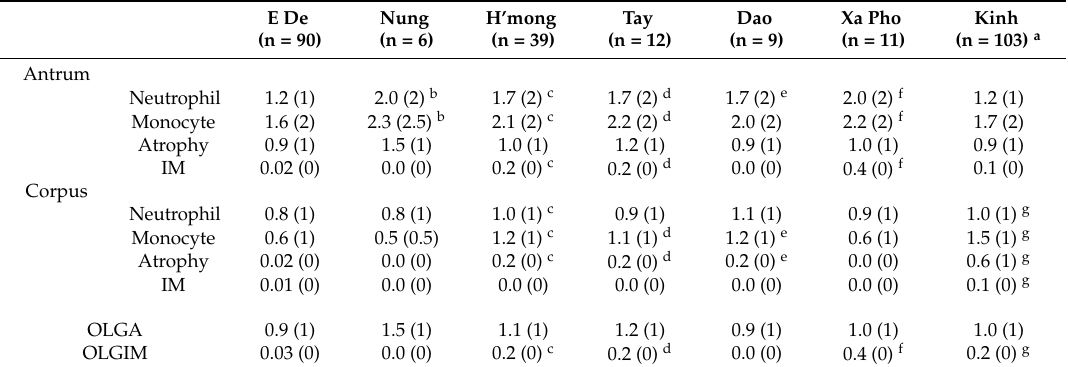
Table 3. Comparison of histological scores between H. pylori infected ethnic